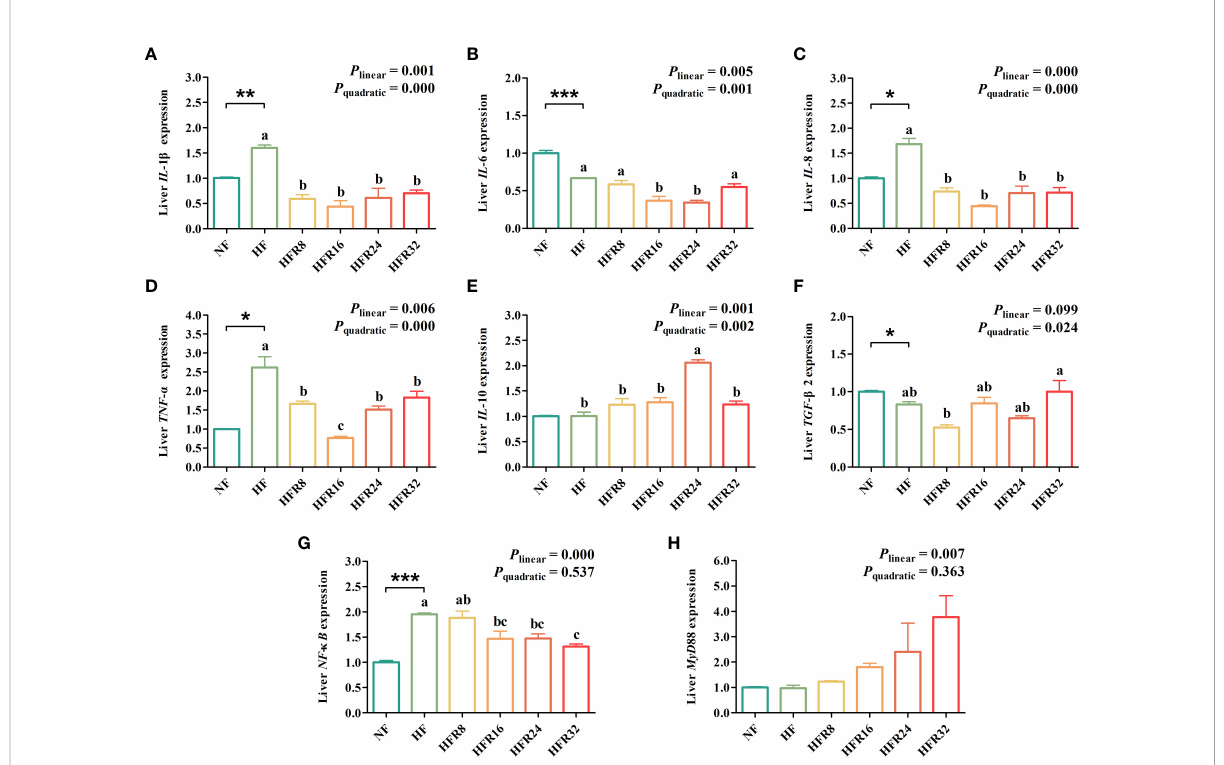
FIGURE 5 Effects of resveratrol supplementation on the hepatic lipid metabolism-related gene expression in common carp ( Cyprinus carpio ). Pro- in fl ammatory-related genes include (A) interleukin-1 b (IL-1 b ), (B) interleukin-6 (IL-6), (C) interleukin-8 (IL-8), and (D) tumor necrosis factor- a (TNF- a ). Anti-in fl ammatory-related genes (E) interleukin-10 (IL-10) and (F) transforming growth factor- b 2 (TGF- b 2). Signaling pathways include (G) nuclear factor kappa-B (NF- k B) and (H) myeloid differentiation factor 88 (MyD88). Data are presented as means ± SEM. “ * ” represented statistical difference between the NF group and the HF group using student ’ s t-test (* P < 0.05, ** P < 0.01 or *** P < 0.001). “ abc ” represented statistical difference among different RSV levels in the HF diet. P -values indicated a linear and quadratic to dietary RSV levels using orthogonal polynomial analysis. Bars with different superscripts are statistically different ( P < 0.05, n =